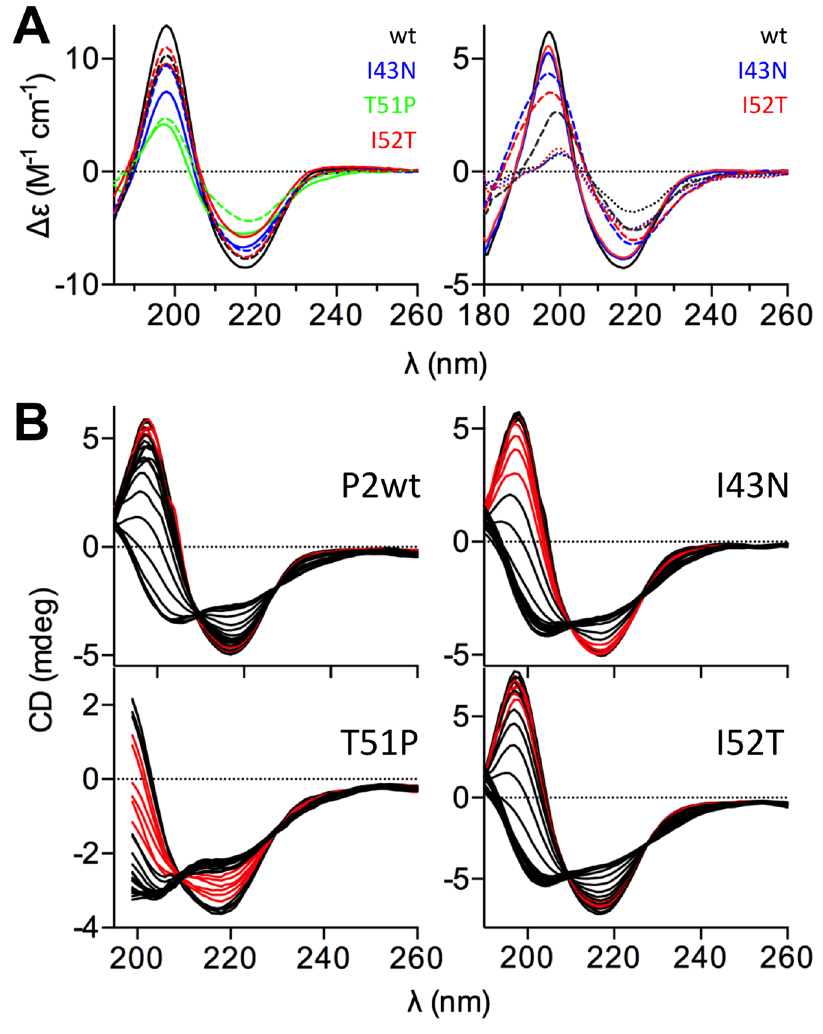
Figure 2. SRCD analysis of P2 folding and membrane interactions. ( A ) Left: SRCD in phosphate buffer with and without DMPC:DMPG vesicles. Right: SRCD in H 2 O and with DMPC:DMPG (dashed lines) and DOPC:DOPG (dotted lines) vesicles. ( B ) Temperature scans of all variants. Temperatures between + 40–50 °C are shown in red for